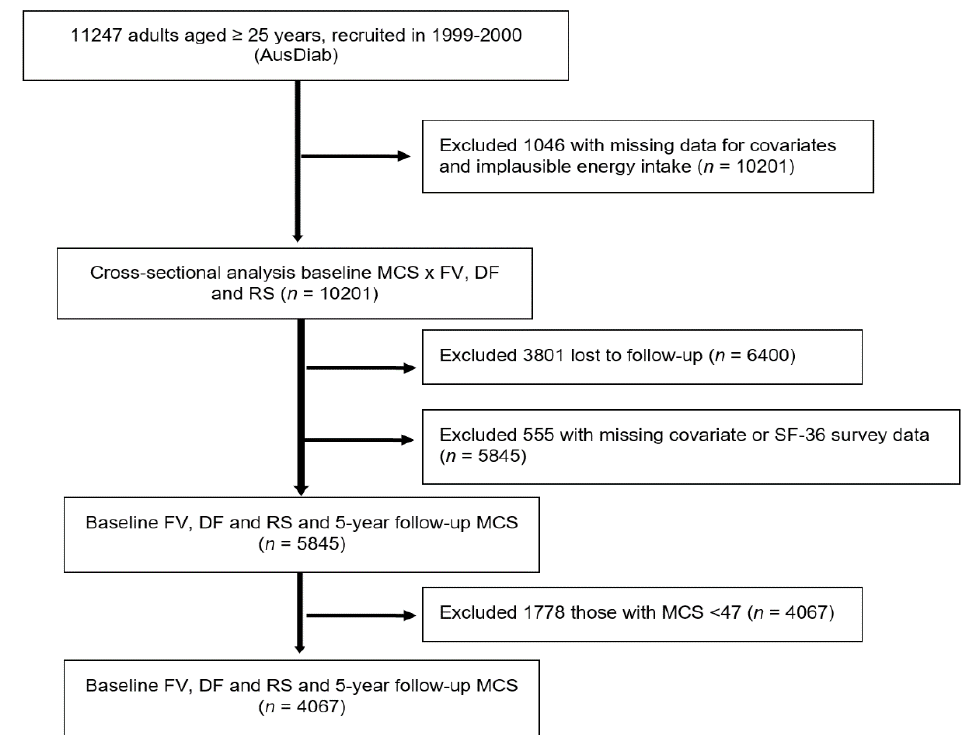
Figure 1. Study flow diagram to show exclusion steps involved and different analyses conducted. DF, dietary fibre; FV, fruit and vegetables combined; MCS, SF-36 Quality of Life Scale—Australian norm-based mental component score median; RS, resistant starch.